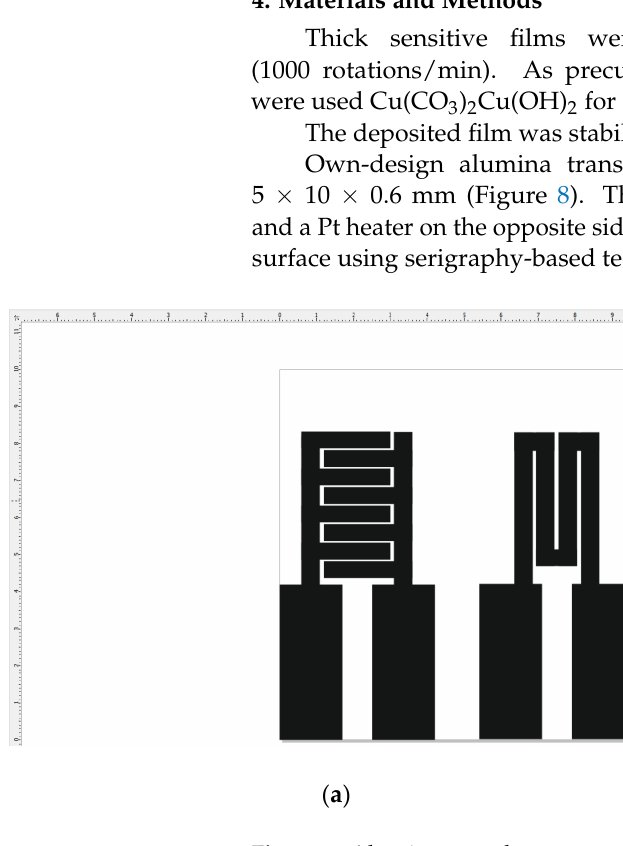
Figure 8. Alumina transducer prototypes for the obtained methane sensors: ( a ) platinum or gold IDE and platinum heater circuit; ( b ) actual S3 sensor sample compared with various objects for sizing purposes.